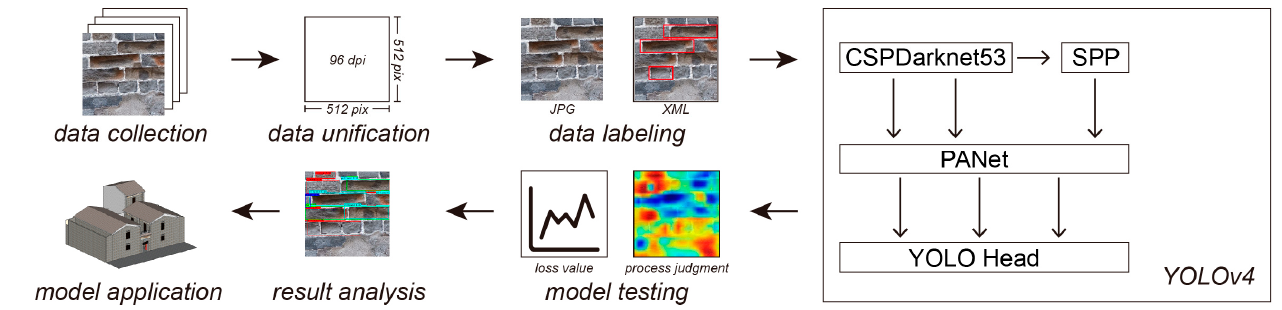
Figure 6. Operational flow of image recognition technology. (Image Source: drawn by the author).